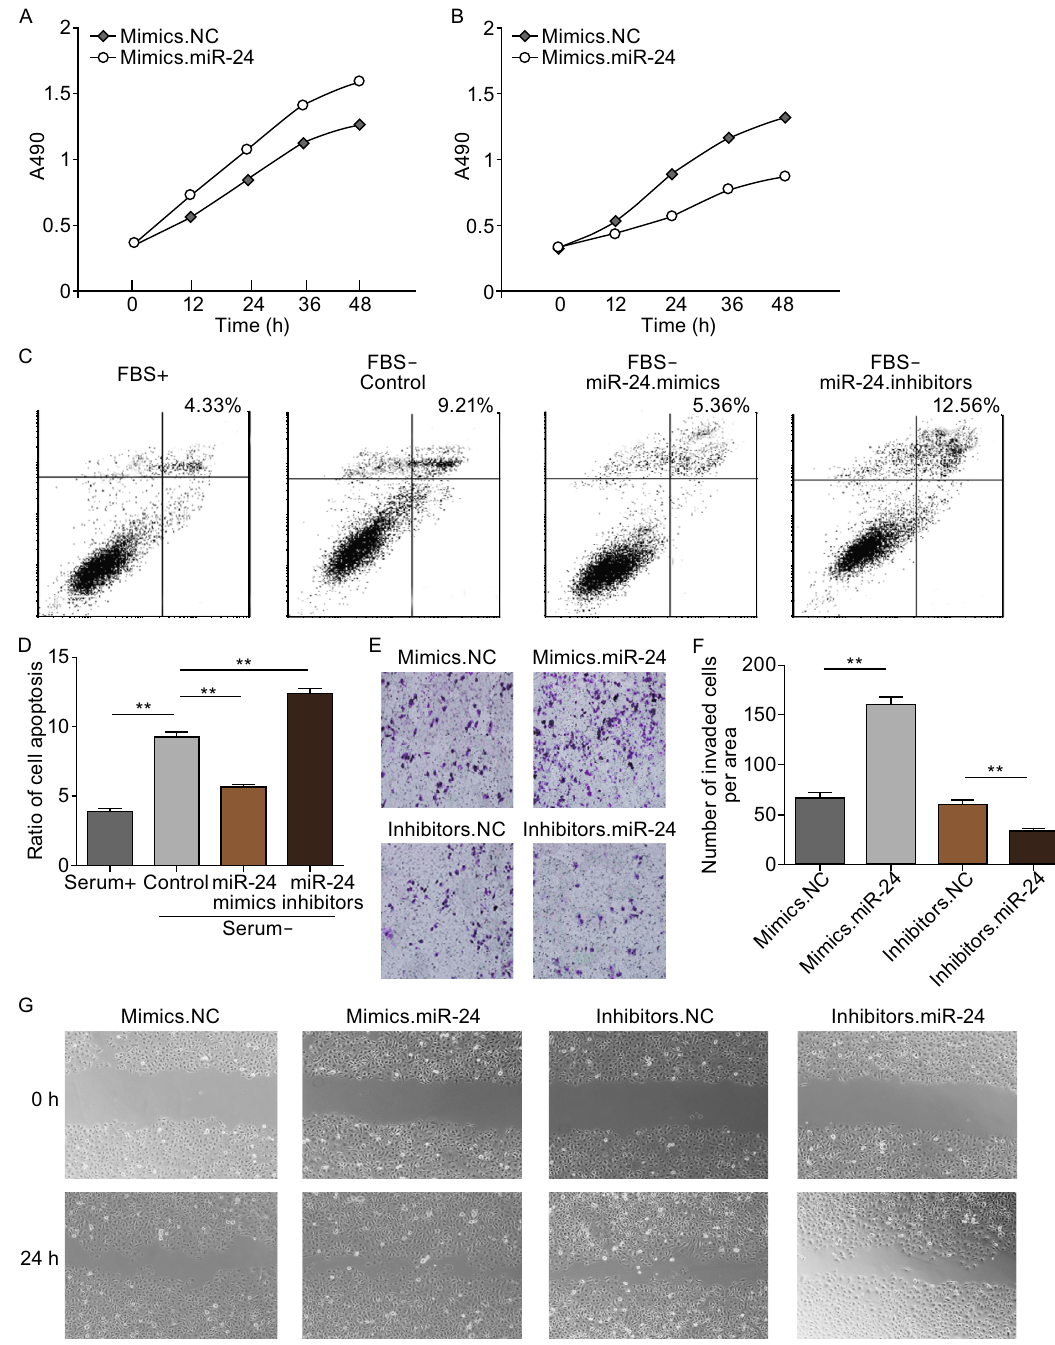
Figure 3. Onco-miR-24 regulates proliferation, apoptosis and migration of GC cells. SGC7901 cells were transfected with miR-24 mimics or inhibitors, and cell growth, apoptosis and migration were evaluated respectively. (A) Overexpression of miR-24 promotes cell proliferation of SGC7901 cells. (B) Knockdown of miR-24 suppress GC cell growth. (C) MiR-24 inhibits cell apoptosis of SGC7901 cells. (D) Quantitative analysis of (C). (E and F) Transwell assays show that miR-24 promotes cell migration of GC cells. (G) Validation of miR-24-mediated cell migration by scraping line method. ** indicates P